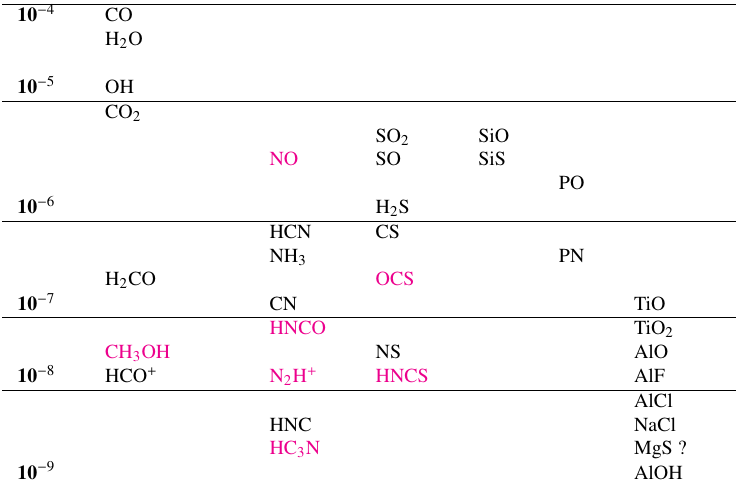
Table shows in color black the 27 molecules detected in oxygen-rich AGB envelopes (from the inventory of molecules in IKTau, o Cet, and RLeo). The molecule MgS, tentatively detected toward OH26.5 + 0.6 [21], is included with the abundance predicted by chemical equilibrium [3]. Also included in color magenta are 7 molecules detected in other oxygen- rich evolved stars, such as OH231.8 + 4.2 (probably in a post-AGB stage) and the massive evolved stars IRC + 10420 and